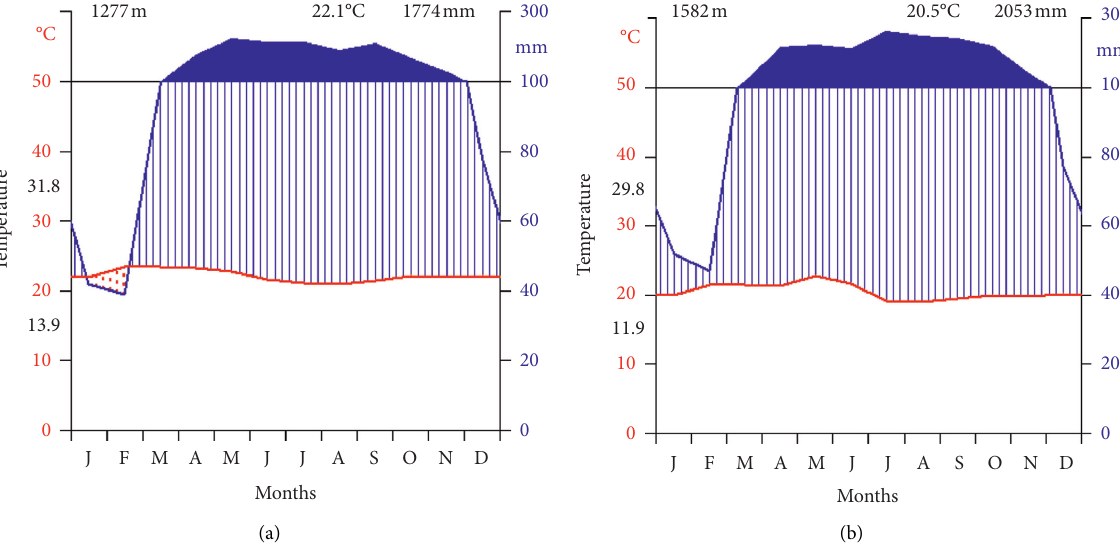
Figure 1: Location of the study area (Site I–IV).